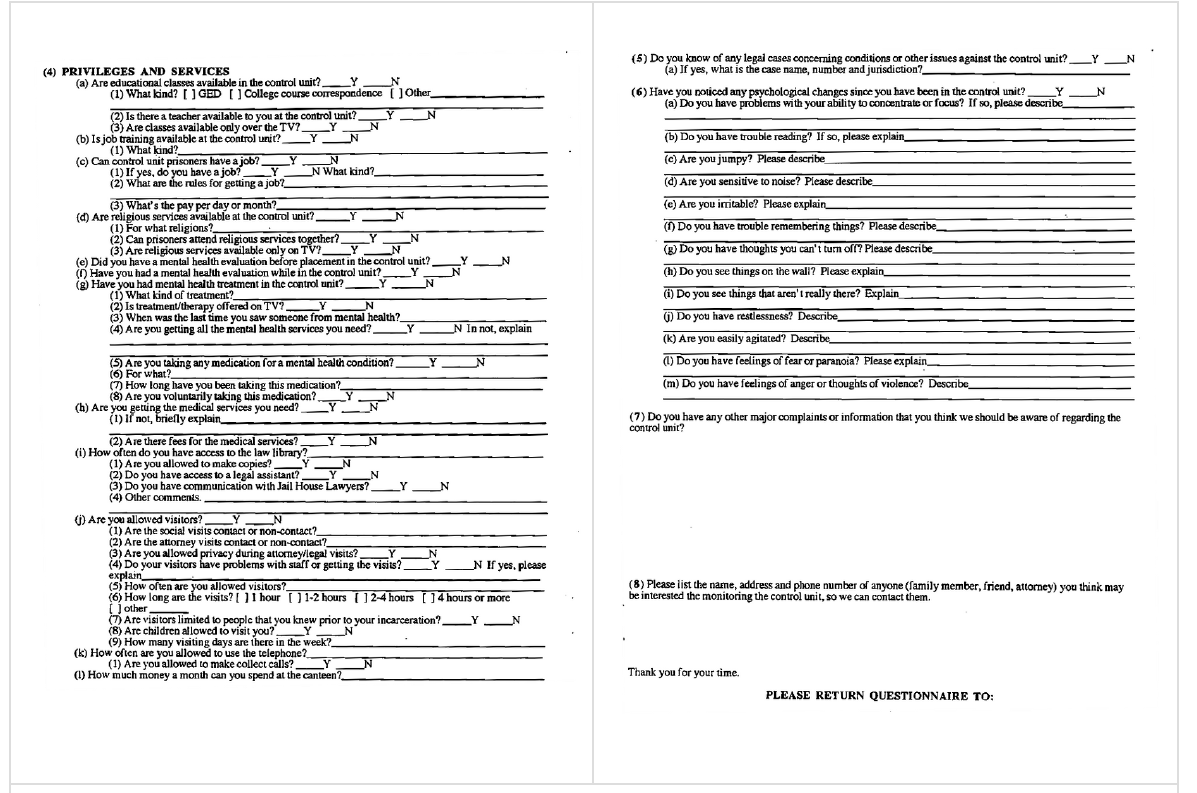
Figure 2. Questionnaire from National Campaign to Stop Control Unit Prisons How to Packet, 1995, Freedom